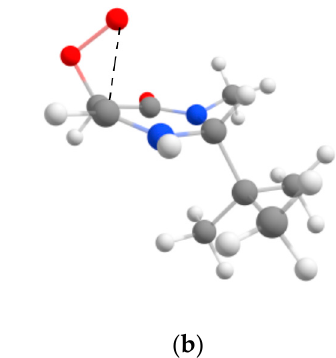
Figure 9 . TS from QST2 calculation starting from the 1 O 2 and 11 ′ as reactants, and: ( a ) the dipolar Figure 9. TS from QST2 calculation starting from the 1 O 2 and 11 (cid:48) as reactants, and: ( a ) the dipolar intermediate, TS1 Z (E = –687.577821 Hartree) or ( b ) the 1,2-dioxetane, TS1 D (E = –687.562242 Hartree) intermediate, TS1 Z (E = − 687.577821 Hartree) or ( b ) the 1,2-dioxetane, TS1 D (E = − 687.562242 Hartree) as product. as product.